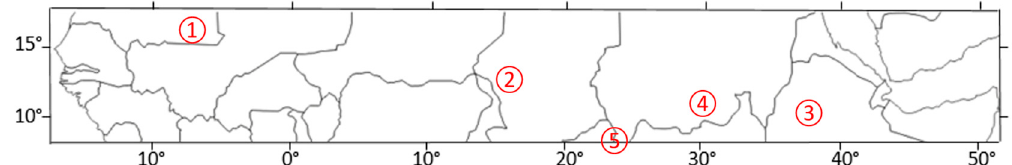
Figure 1. Locations of study sites: 1. Koumbi Saleh, Mauritania; 2. Fadj˙e, Chad; 3. Kem Kem, Ethiopia; 4. Abyie, Sudan; 5. Quarda Djall˙e, Central African Republic.